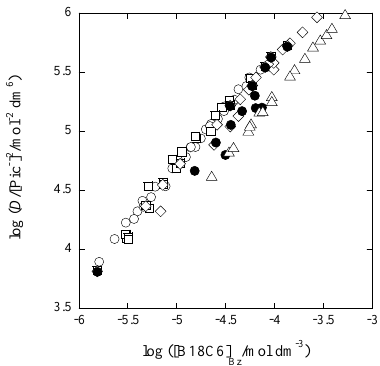
Figure 1. Plots for composition determination based on Equation (1a) under the conditions of [Cd] t /[Pb] t = 0 (open circle), 1.06 (square), 26.6 (diamond), 88.5 (full circle), and 178 (triangle).